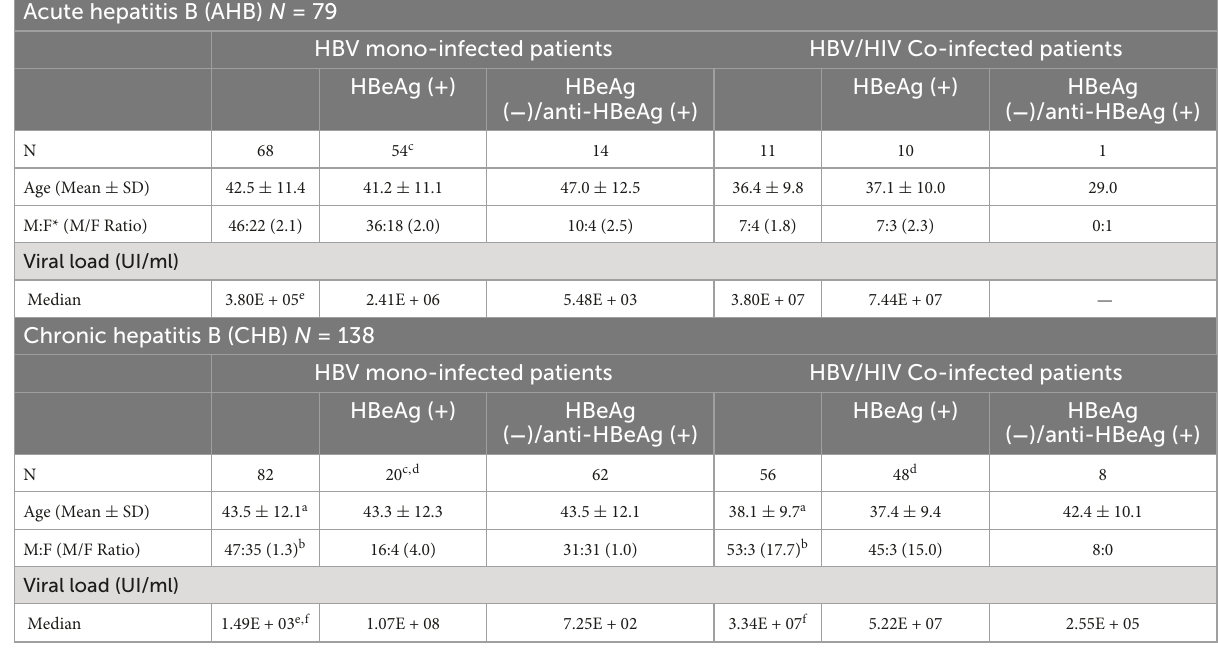
( Figure 2 ). Sub-genotypes distribution was different between mono- and co-infected patients ( Figure 3B ). In the 82 HBV- mono-infected sgt F1b was present in 34.1% of cases, followed by sgt F4 (23.2%) and A2 (15.9%). The gt D, sgt F6 and gt C were present in 14.6, 6.1, and 2.4% of cases, respectively.